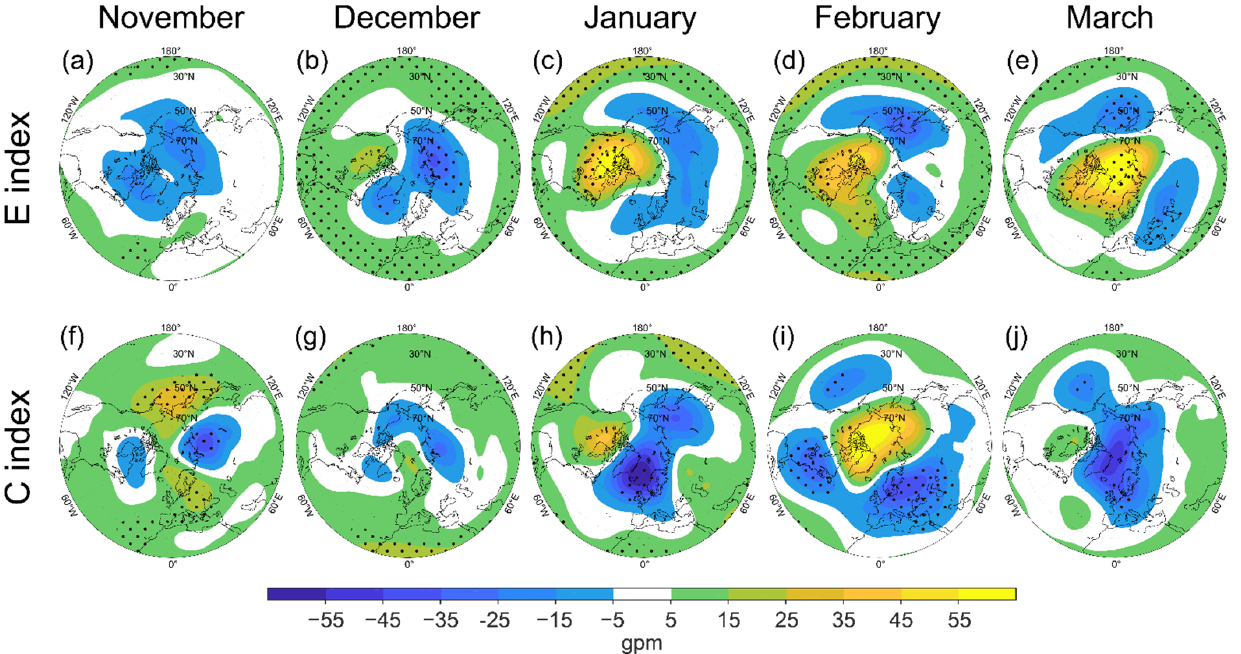
Figure 3. Regression of geopotential height anomalies at 70 hPa onto ( a – e ) E index and ( f – j ) C + index from November to March. Dotted areas represent statistically significant values at a 90% confidence level. Contour interval is 10 gpm. The outermost latitude is 20° N.